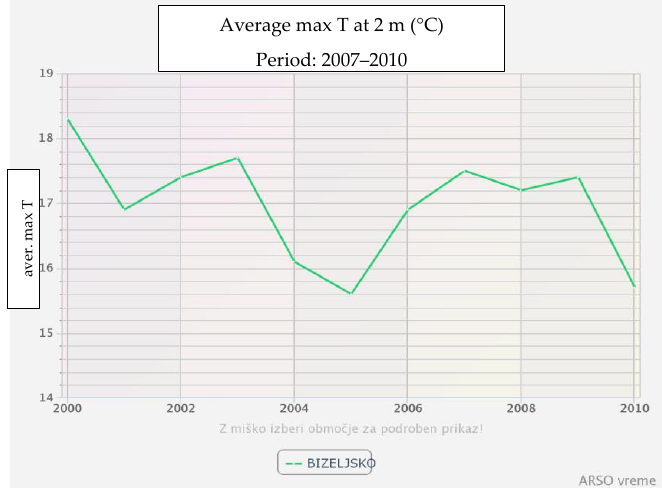
Figure 7. Average maximum temperature for localities 13—Podsreda, measured from nearby climate station Bizeljsko (source: https://meteo.arso.gov.si/met/sl/archive, accessed on 27 January 2023).